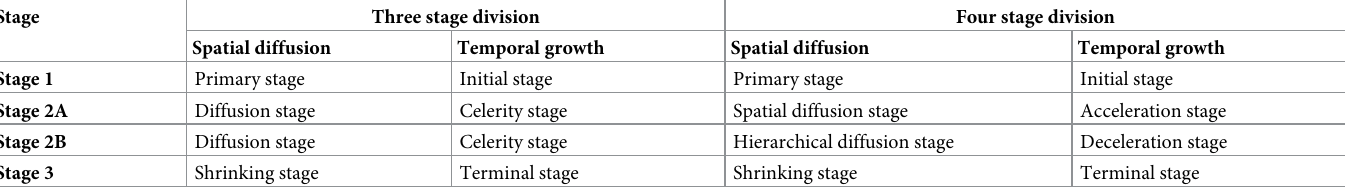
Table 5. The stage division and comparison of time and space diffusion